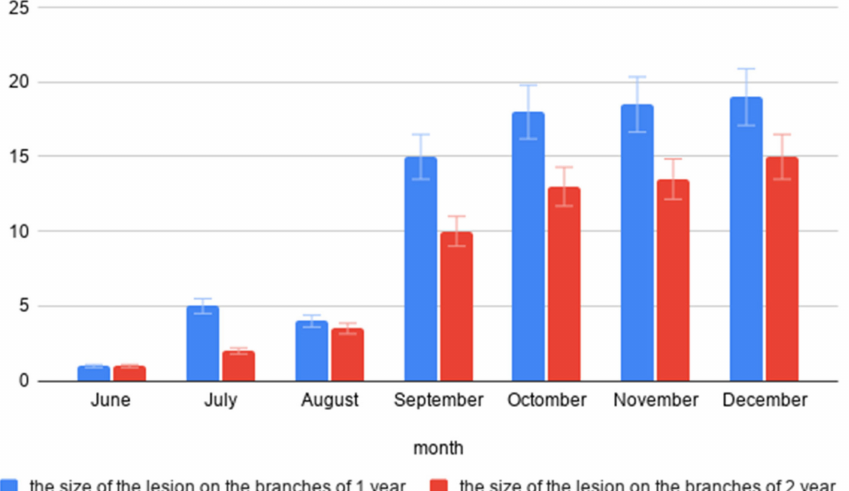
Figure 2. The development of the lesions (cm) from the date of inoculation of the branches with Phomopsis juglandina .